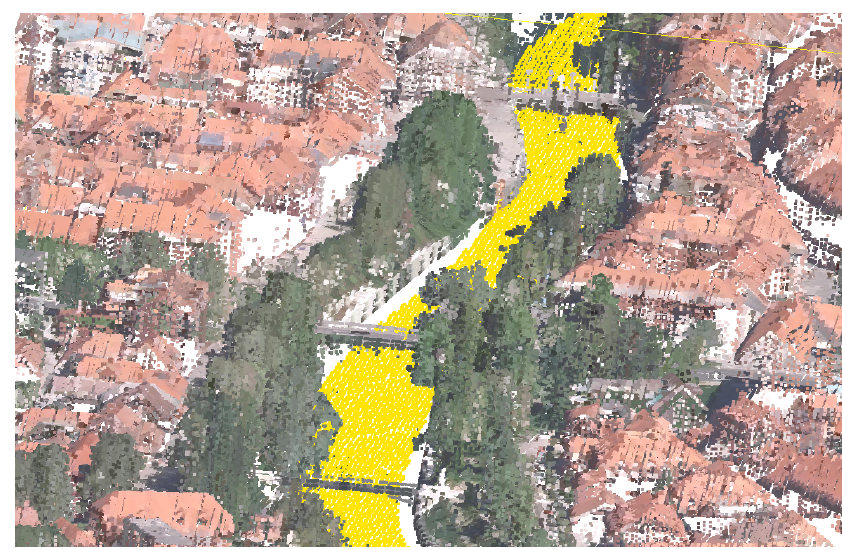
Figure 15. Water reconstruction works well also under the bridges.